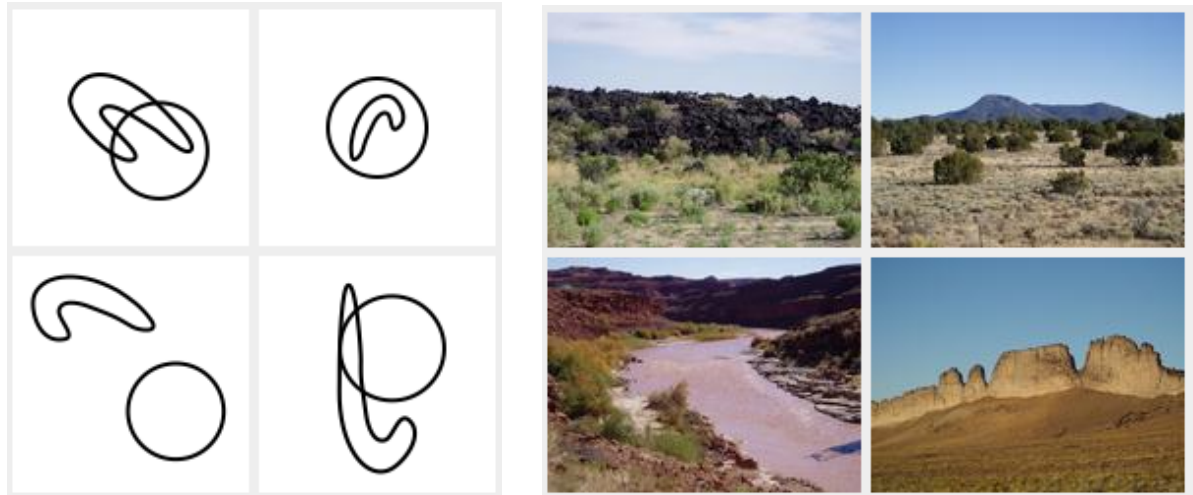
Figure 5: Example of the icons used in the Mode of Overlap experiment (left) and the Navajo Landscape Concepts (right). Heinzelman, J. and Waters, C., 2010. Crowdsourcing crisis in- formation in disaster-affected Haiti. Special Report 252, United States Institute of Peac, Washington,